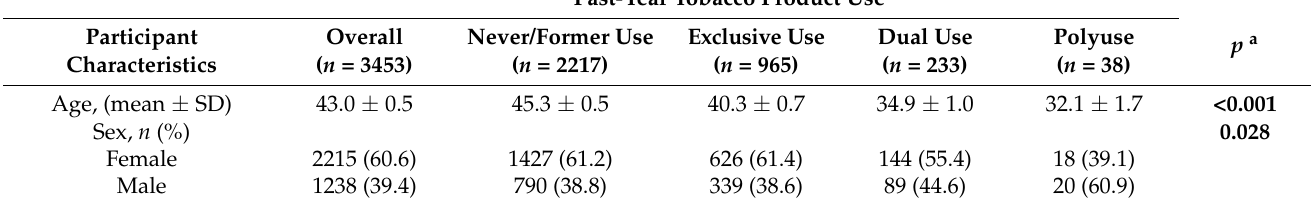
Table 1. Distributions of Participant Characteristics Overall and by Past-Year Exclusive, Dual, and Polytobacco Use ( n =